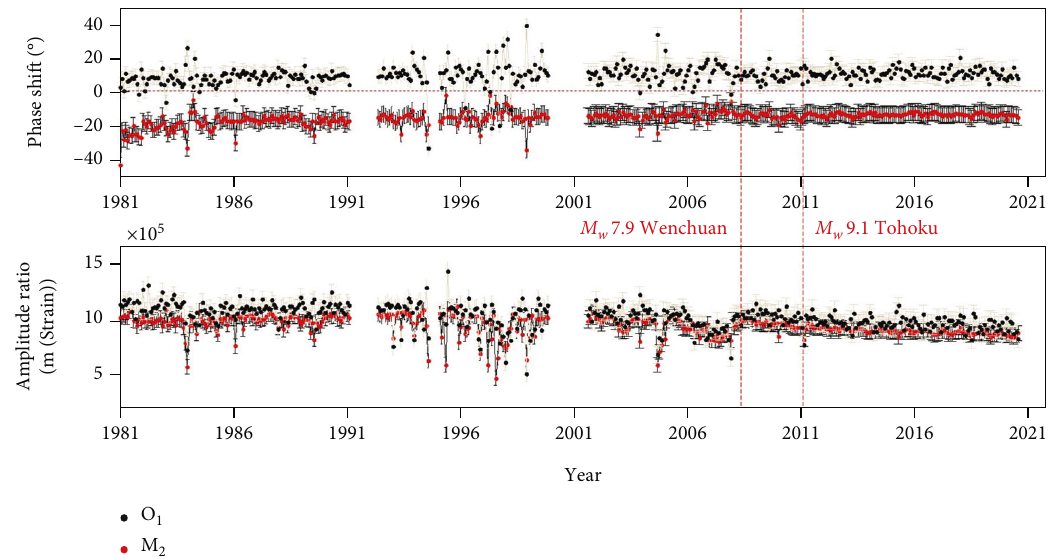
Figure 3: The phase responses over time (from January 1st, 1981, to May 9th, 2020) for well Gaocun at the M (black dots) frequencies. The horizontal dashed line represents the 0 ° phase shifts, from which we can see the obviously separated M phase shifts. The vertical dashed lines represent the start time of the 2008 Wenchuan and the 2011 Tohoku huge earthquakes, which had not caused obvious in fl uence on the phase shifts or the amplitude ratios. ∗ We calculated the errors based on the data from Jan. 1st, 1981, to Dec. 31st, 1990 (which is relatively stable and continuous), and obtained the error of the phase shifts of the M with 4.32 ° , and obtained the error of the amplitude ratios of the M